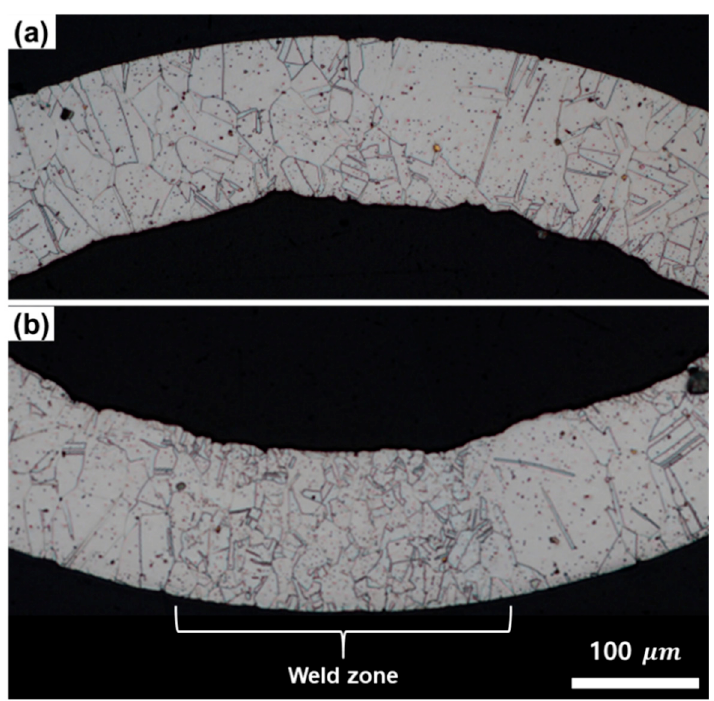
Figure 3. Metallographs at the radial cross-section of the tube: ( a ) typical base metal region and ( b ) region including the weld zone.